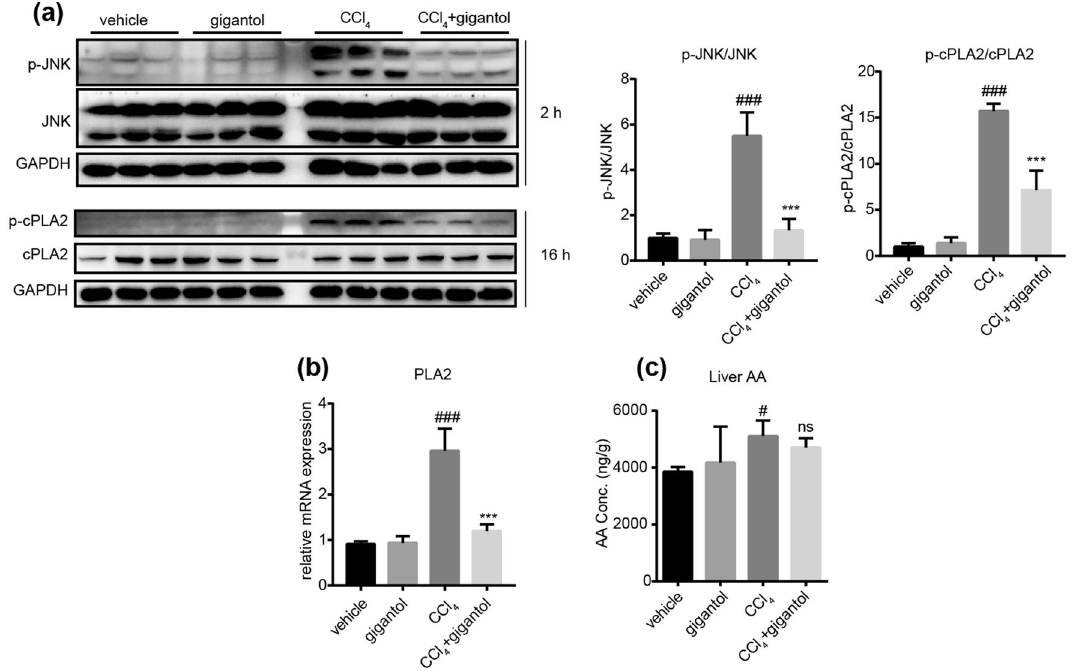
Figure 3. Effect of gigantol on the JNK and cPLA2 activation in livers induced by CCl 4 . ( a ) The protein expression of p-JNK, JNK, p-cPLA2 and cPLA2 in mice with or without gigantol pretreatment (40 mg kg −1 d −1 , po , for 7 days) at 2 h or 16 h post CCl 4 injection. The representative western blot bands are shown, n = 3 western experiments. The ratio of p-JNK/JNK and p-cPLA2/cPLA2 is quantified on the right. ( b ) The mRNA expression of PLA2 in the mouse livers were measured by real-time PCR. ( c ) The concentration of AA in the livers was measured by UPLC/MS/MS. The above results are shown as the mean ± SD, n = 6 mice in each group. ### P < 0.001, ## P < 0.05 versus the vehicle group; *** P < 0.001 versus the CCl 4 group; ns means non-significance. Full-length blots are presented in Supplementary Figure